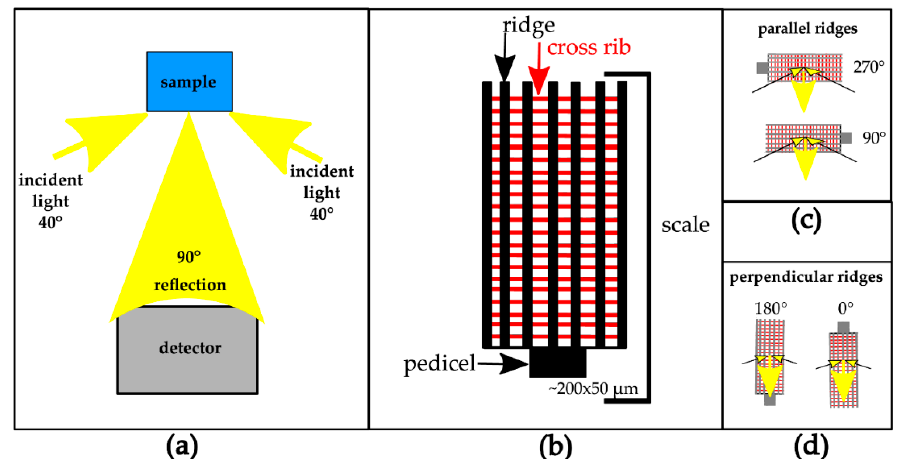
Figure 1. ( a ) Sketch of the experimental setup of the orientation-dependent reflectance measurements: the sample is illuminated with a two-branch flexible light guide at fixed angles of 40° and the reflection is detected along the surface normal of the sample (see Figure S3 for detailed photos of the experimental setup). ( b ) Sketch of the typical structure of the upper lamina of Lepidopteran wing scale, which features ridges (black lines) and cross-ribs (red lines). ( c,d ) Sketches of the sample orientation with ridges oriented either parallel ( c , 90° and 270°) or perpendicular ( d , 0° and 180°) to the incident light.